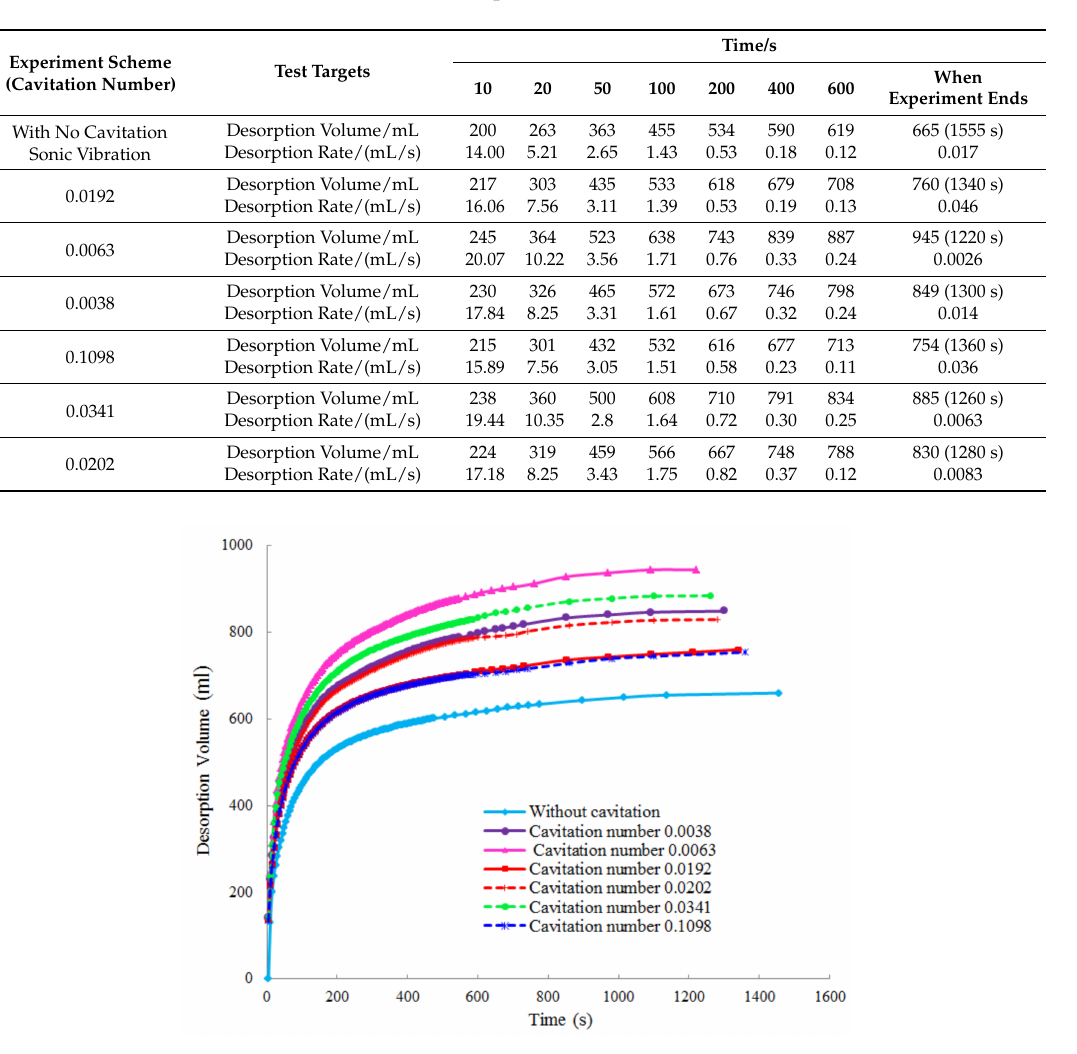
Table 4. Gas Desorption Volume and Rate.